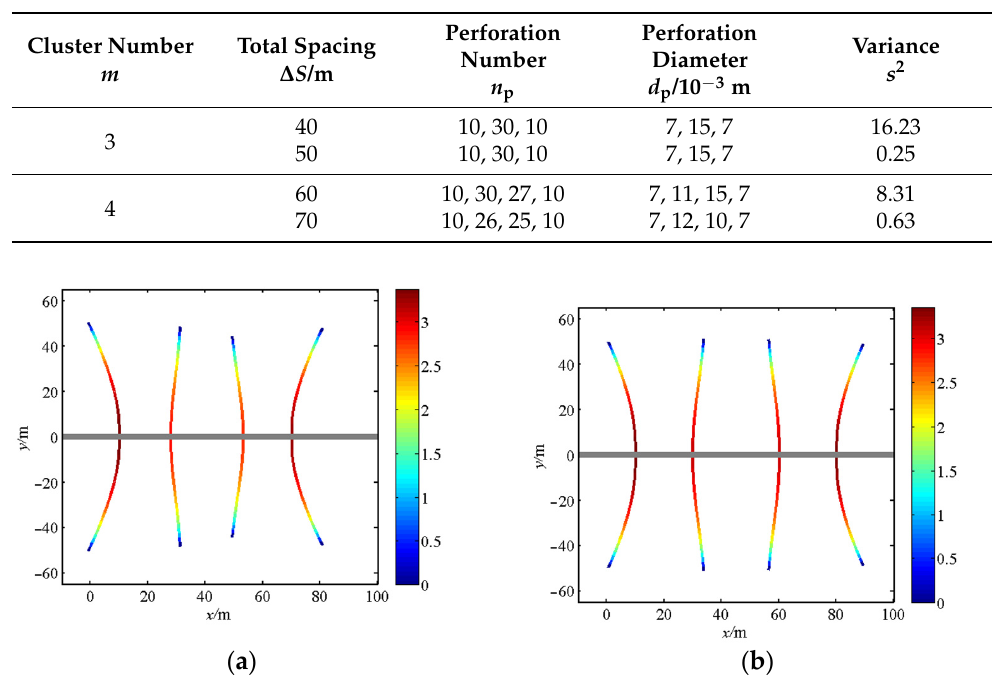
Table 2. The optimization results of perforation parameters.